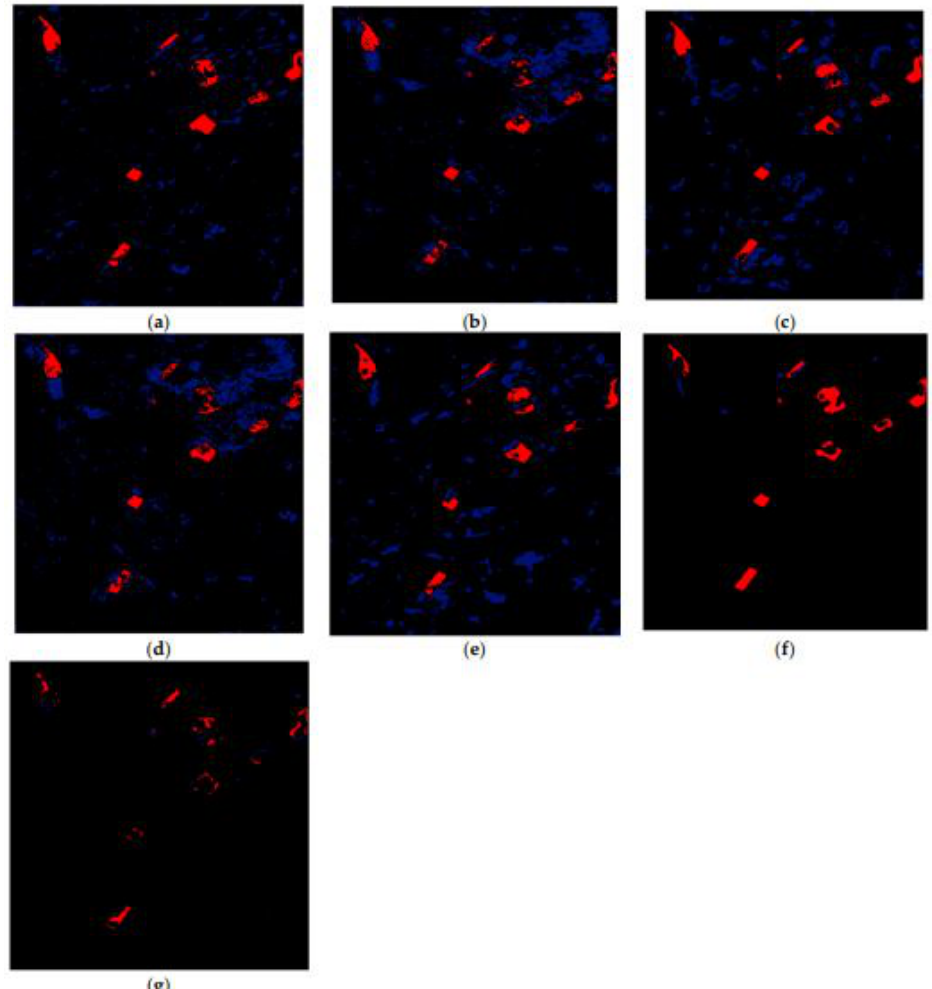
Figure 7. CD results for multispectral-Saclay images ( a ) CVA-SVM, ( b ) MAD-SVM, ( c ) PCA-SVM, indicate TP and TN, FN, and FP